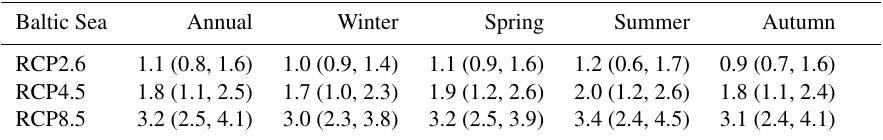
Table 14. Sea surface temperature (SST) changes (degrees Celsius) between 1976–2005 and 2069–2098, averaged over each season, and the annual mean over the Baltic Sea calculated from nine dynamically downscaled ESM simulations. In addition to the ensemble mean change, the 5th and 95th percentiles indicating the ensemble spread are listed (in parentheses). Data source: Gröger et al.,